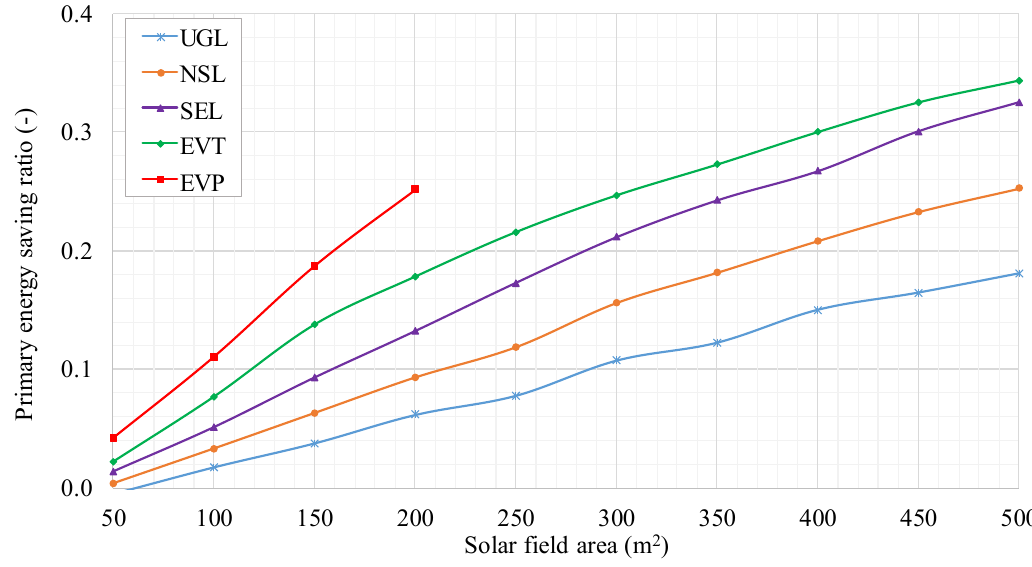
Figure 12. Primary Energy Saving ratio vs. solar field area, parametric analysis.